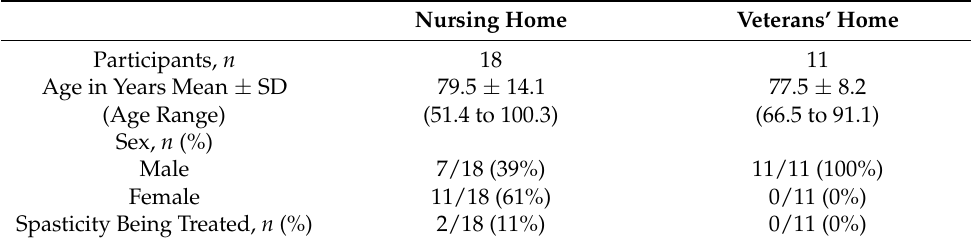
Table 1. Participant